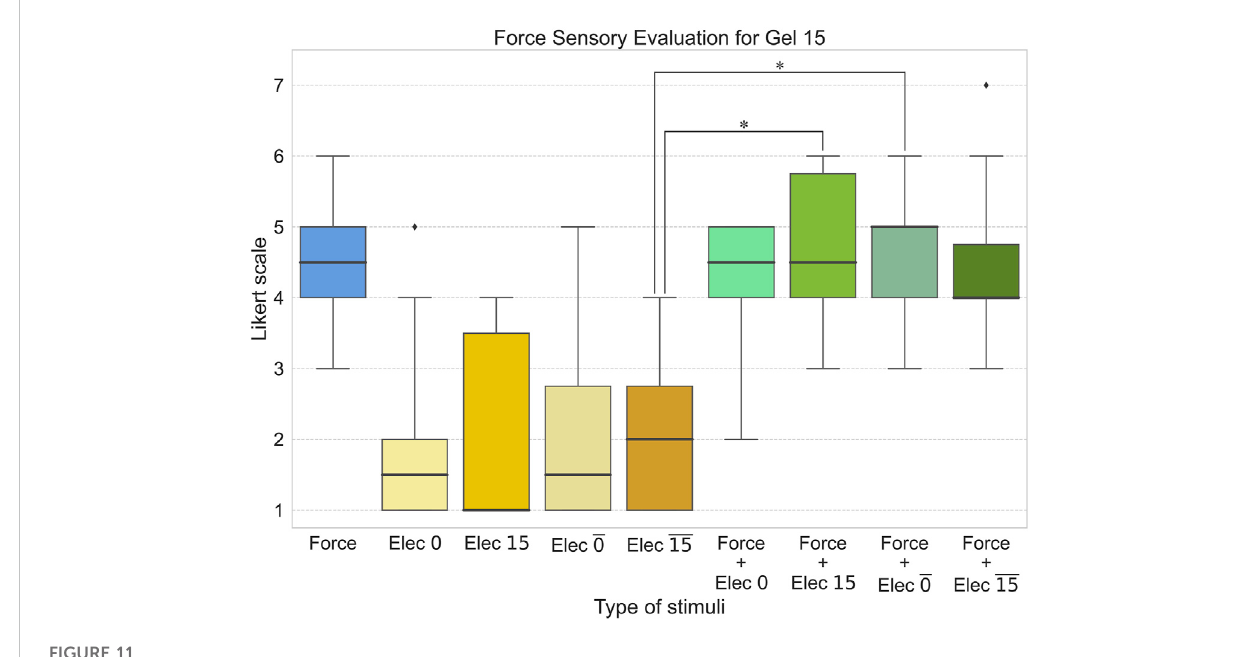
Subjective evaluation of force sensation for Gel 15 (*: p < 0.05)